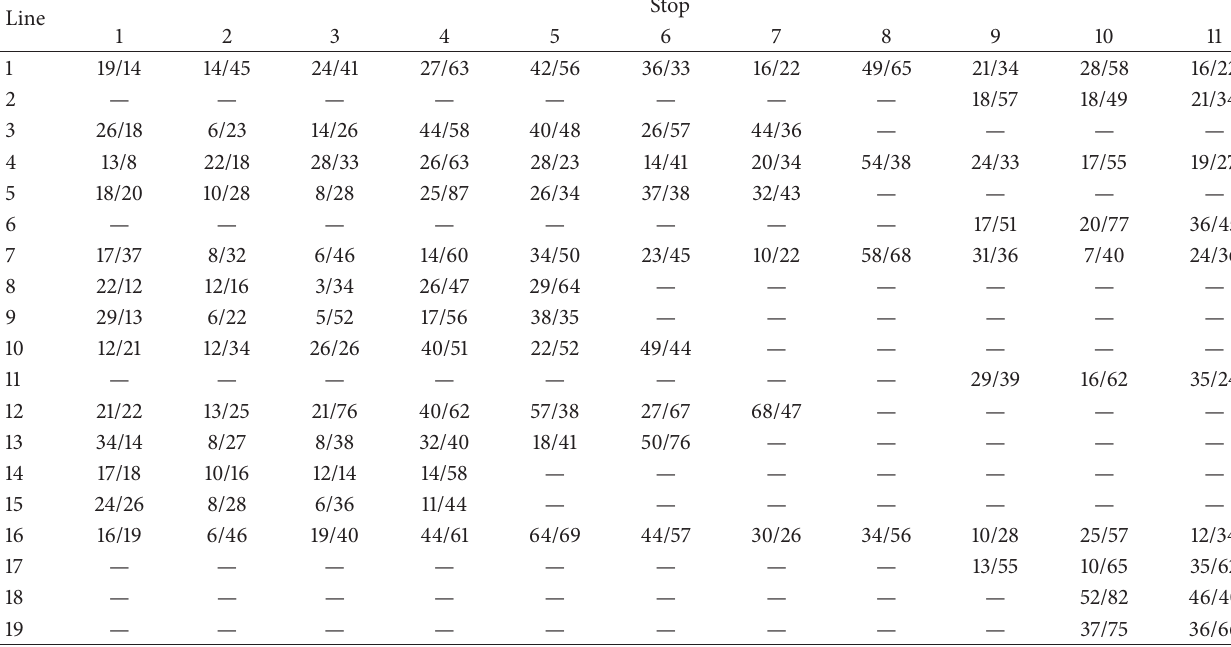
Table 4: Numbers of passengers boarding and alighting at stops (from west to